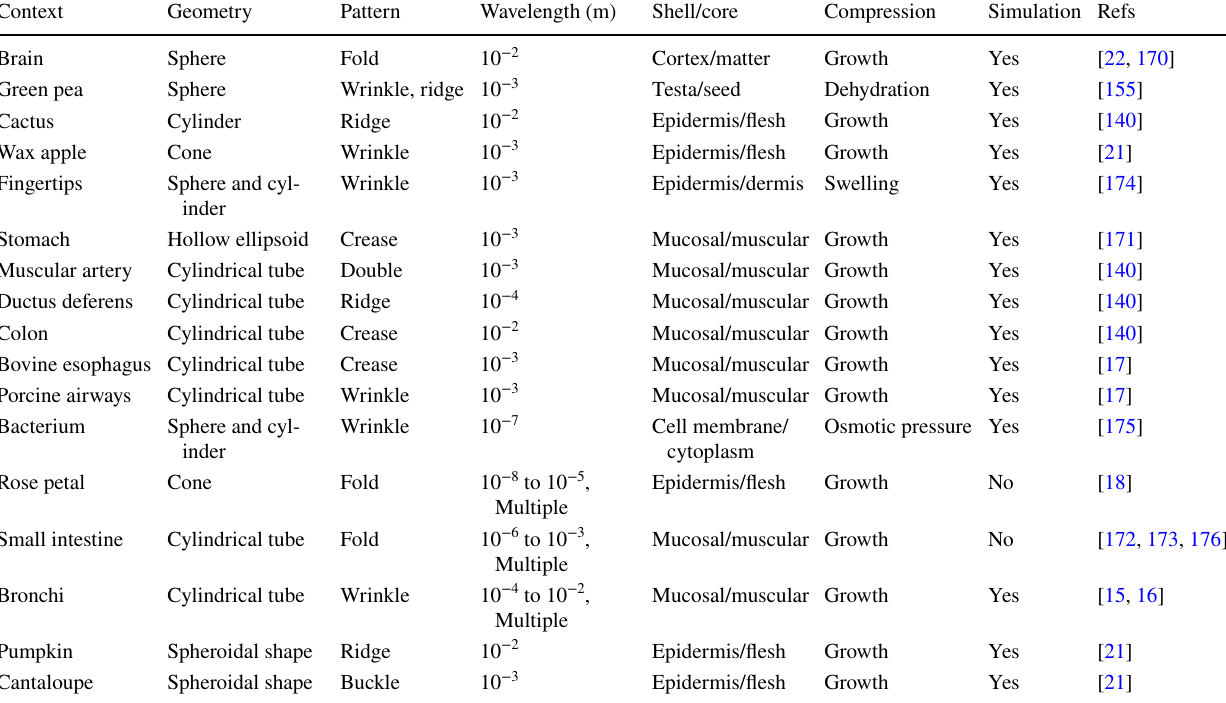
Table 1 Examples of wrinkling patterns on curved substrates observed in nature and corresponding simulation